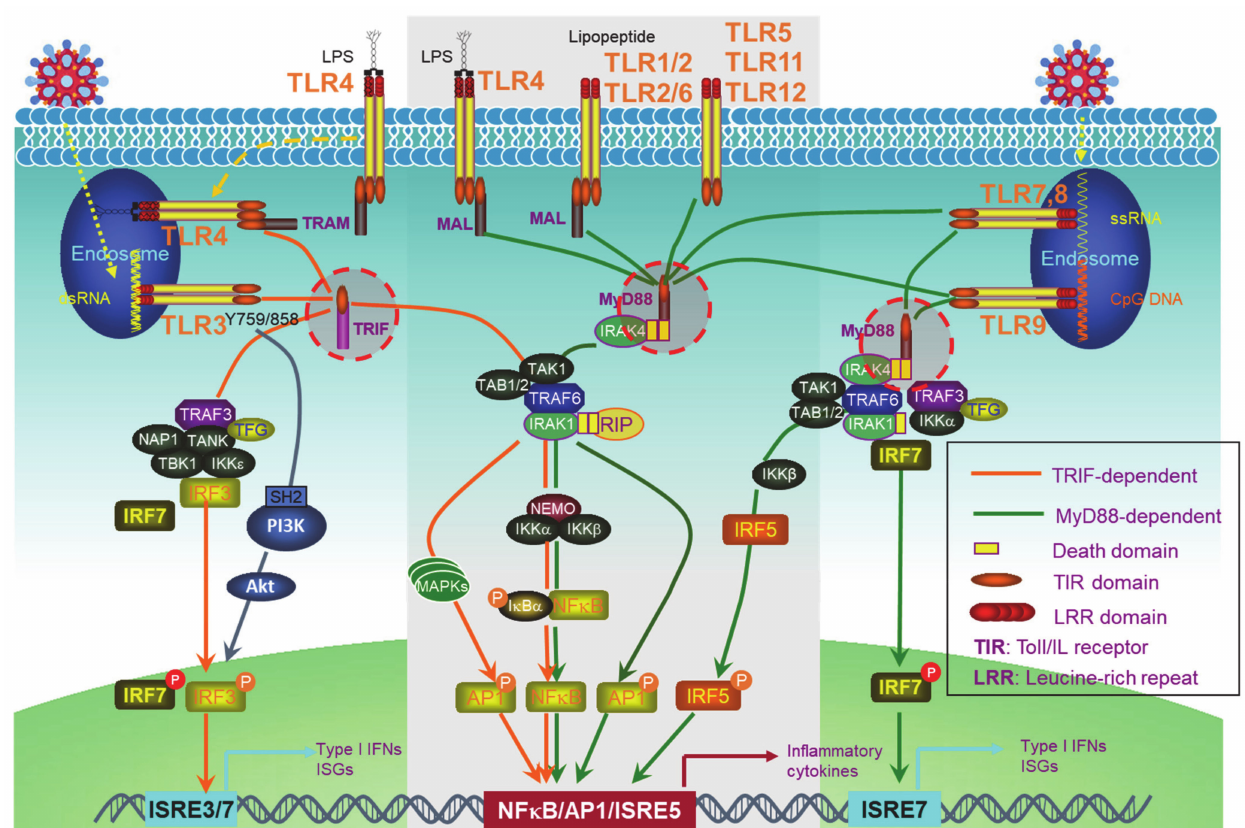
Figure 1. Toll-like receptor (TLR)signaling pathways. The TLR family has 13 members, among which, endosomal TLR3, -7, -9, and murine TLR8, and endocytic TLR4 are able to trigger signaling for IFN-I production. TLRs that cannot trigger the activation of Interferon regulatory factors (IRFs) (The middle part in the gray frame) do not contribute to IFN-I production. All the TLRs have a TIR domain in the cytoplasm, which recruits adaptor proteins also with a TIR domain at their C-terminus. TRIF and MyD88, two adaptor proteins, bridge all TLRs to downstream signaling molecules, leading to the activation of NF κ B, IRFs, and AP1. IRF1, -3, -5, -7, and -8 are the transcription factors for both IFN α and IFN β transcription in different cell contexts, but a full IFN β transcription requires the enhanceosome complex that contains NF κ B, IRF3, -7, ATF-2/c-Jun, and HMGIY (high mobility group I(Y)). ISRE: Interferon-stimulated response element. ISRE3/7: ISRE that binds to IRF3//7. ISRE7: ISRE that binds to